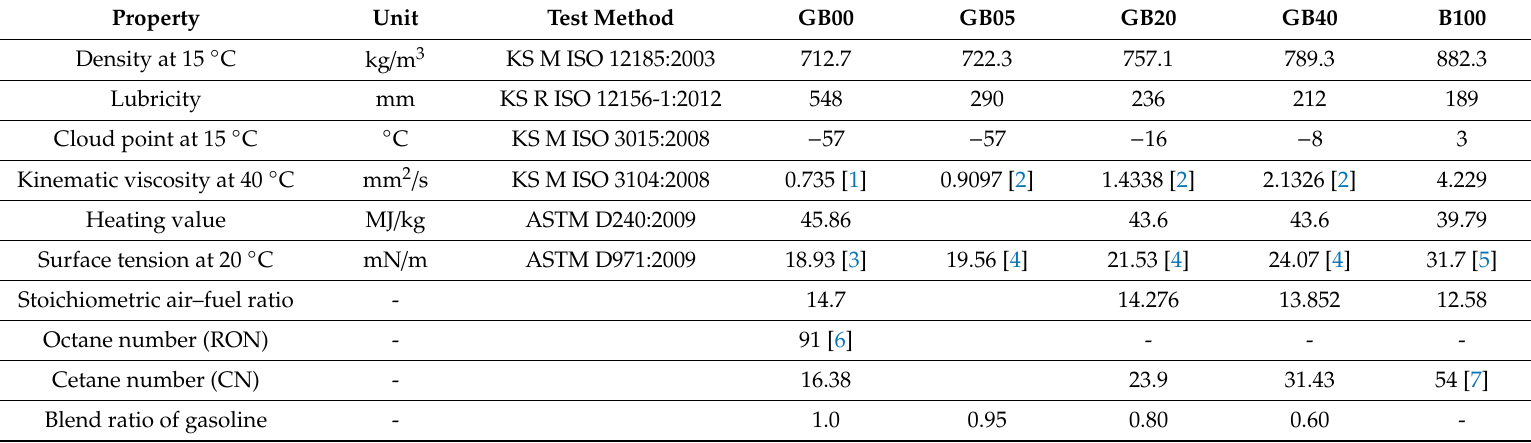
Table 1. Physical properties of the GB00 (neat gasoline), GB05, GB20, and GB40 fuels used in this study